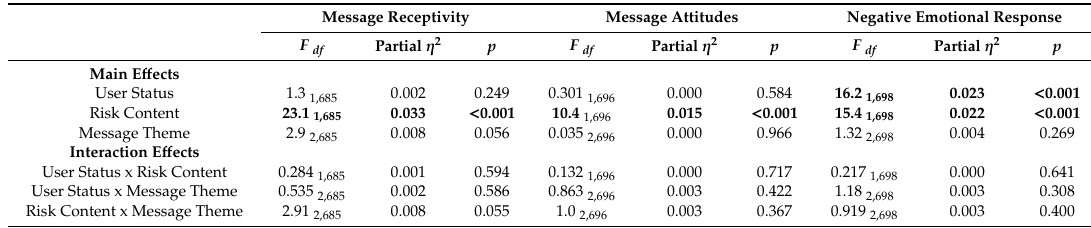
Table 3. Analysis of variance results for message